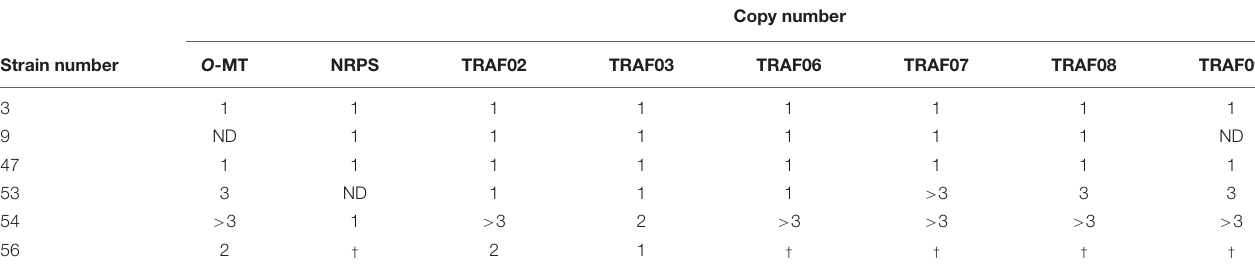
FIGURE 5 | Expression of all genes introduced into A. oryzae . Expression of the genes required for KK-1 biosynthesis in A. oryzae strains 3, 9, 47, 53, 54, and 56 grown for 24 h in YPM medium. qRT-PCR was used to determine the levels of transcription of the indicated genes by using gene-specific primers. Each value represents the ratio of expression to that of the histone H4 gene in each strain. Error bars represent standard deviations (three biological and two technical replicates). ND, not detected. TABLE 1 | Copy numbers of genes involved in KK-1 biosynthesis that were introduced into Aspergillus oryzae